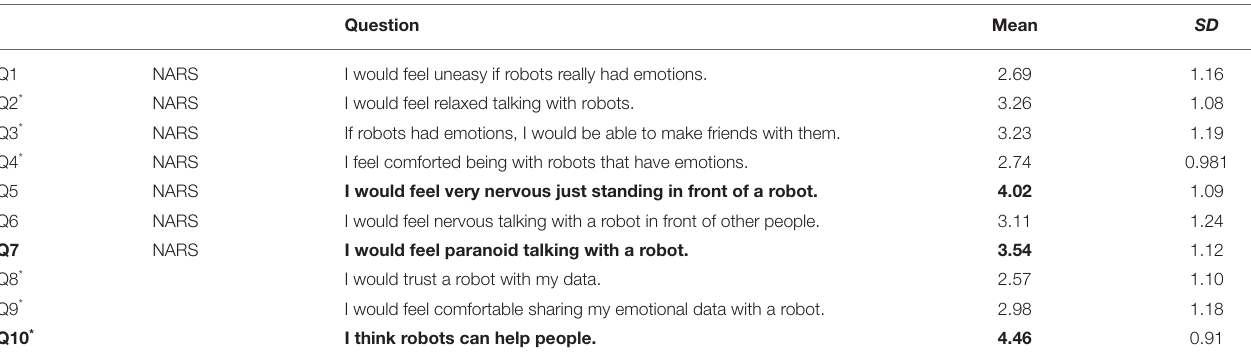
TABLE 2 | Baseline measurement of teen attitudes toward robots.